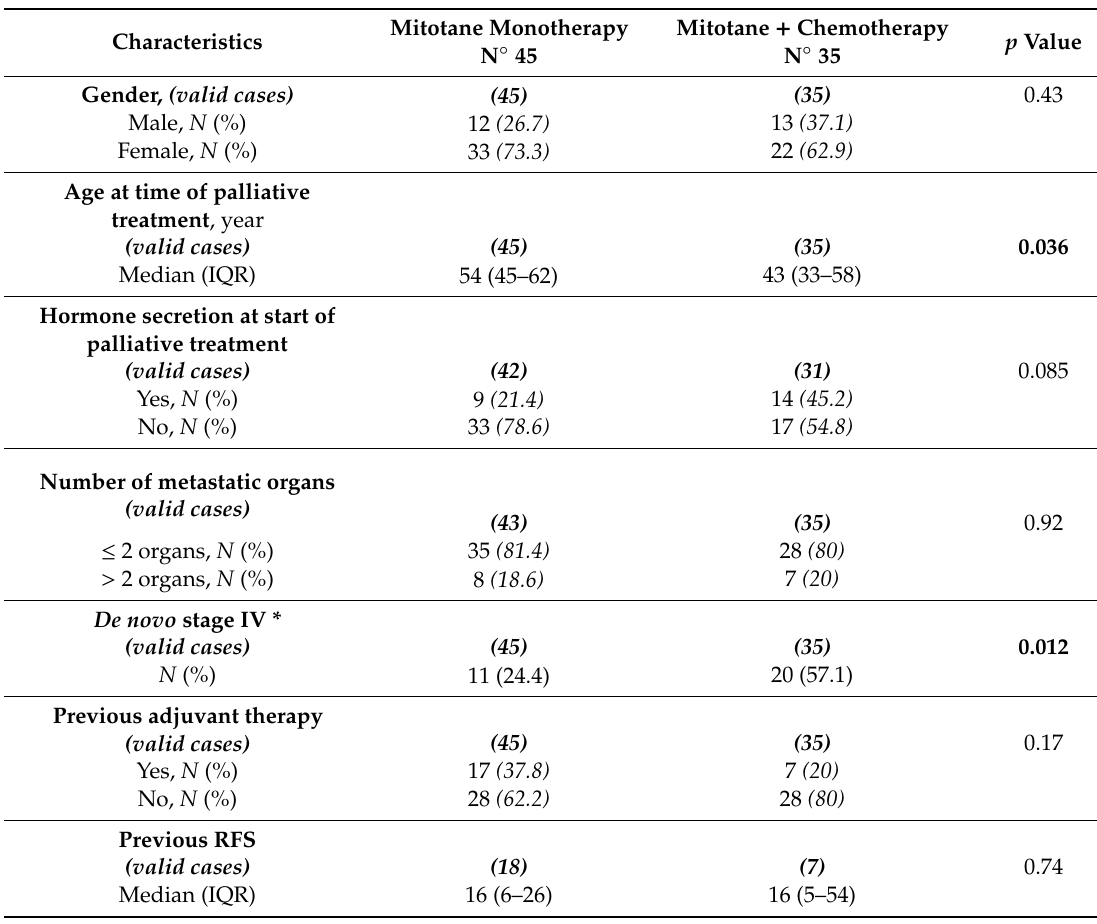
Table 2. Comparison between patients starting palliative treatment with mitotane monotherapy vs. patients starting with the association mitotane +